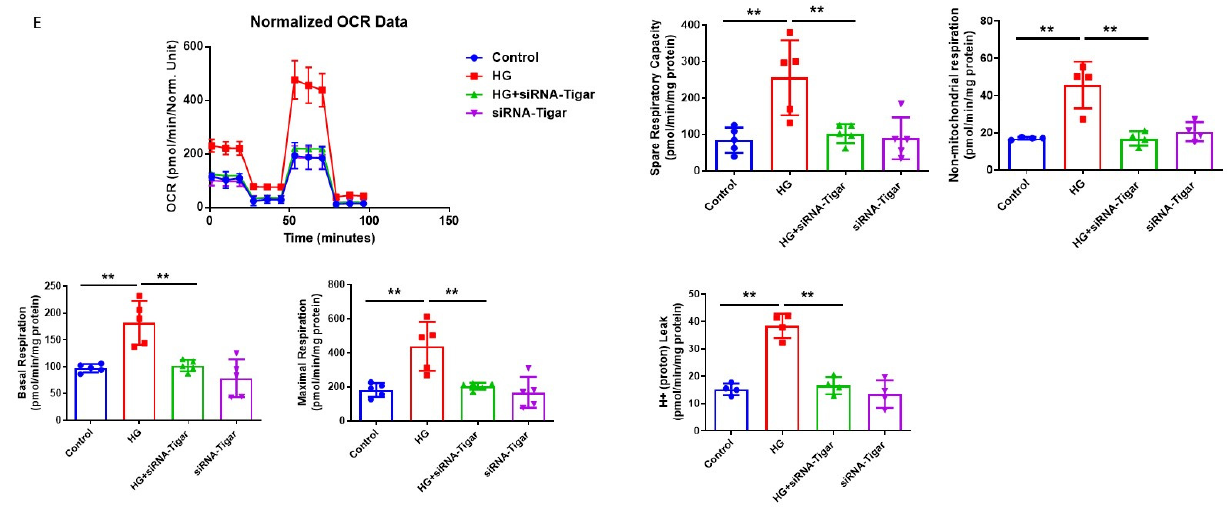
Figure 4. Knockdown of TIGAR improves cardiomyocyte PHDs-HIF- α signaling under HG conditions. ( A ) Western blot analysis revealing that exposure of H9c2 cells to different concentrations of glucose (15, 30, 45 mM) for 72 h resulted in a dose-dependent increase in TIGAR expression as compared to normal glucose (5.5 mM). Densitometries showed a significant upregulation of TIGAR expression at 30 mM and 45 mM concentrations. Data represent mean ± SD (n = 3 per group, * p < 0.05 and ** p < 0.01). ( B ) Knockdown of TIGAR blunted HG (30 mM)-induced upregulation of PHD1 and PHD2. Data represent mean ± SD (n = 3 per group, * p < 0.05 and ** p < 0.01). ( C ) Knockdown of TIGAR reversed HG (30 mM)-induced downregulation of HIF-1 α and HIF-2 α expression. Data represent mean ± SD (n = 3 per group, ** p < 0.01). ( D ) Immunostaining revealing that knockdown of TIGAR significantly reduced FSP-1 levels in H9c2 cells under HG (30 mM) conditions (20X Magnification). All data represent mean ± SD (n = 3 per group, ** p < 0.01). ( E ) Knockdown of TIGAR attenuated HG (30 mM)-induced increases in basal respiration, maximal respiration, spare respiration, non-mitochondrial respiration, and proton leak in H9c2 cell lines. All data represent mean ± SD (n = 5, ** p < 0.01). Circle, square and triangle were denoted the different experiment groups as indicated in the